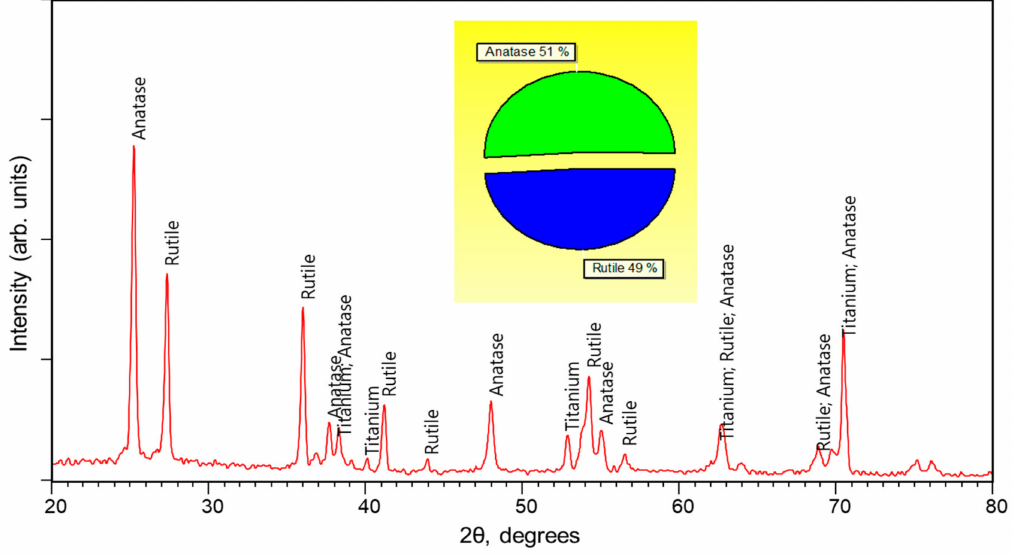
Figure 2. XRD pattern of the PEO coating with the labeled peaks and SemiQuant